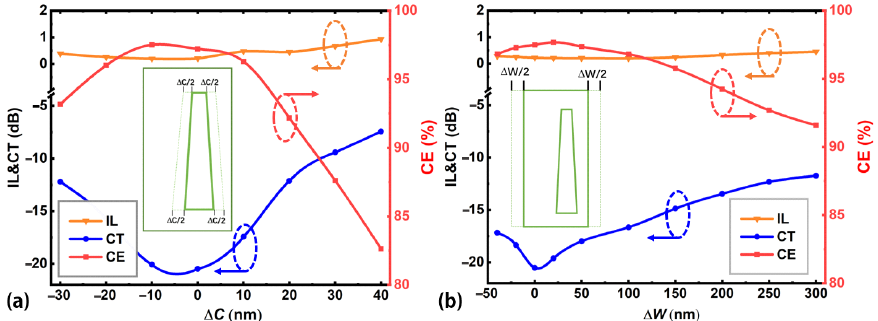
Figure 7. Fabrication tolerance analyses. Device performance as a function of the variation in the size of the ( a ) embedded Sb 2 Se 3 layer Δ C and ( b ) silicon waveguide Δ W along the width direction. Insets in Figure 7a,b show the definition of Δ C and Δ W in the calculated waveguide structures, respectively.